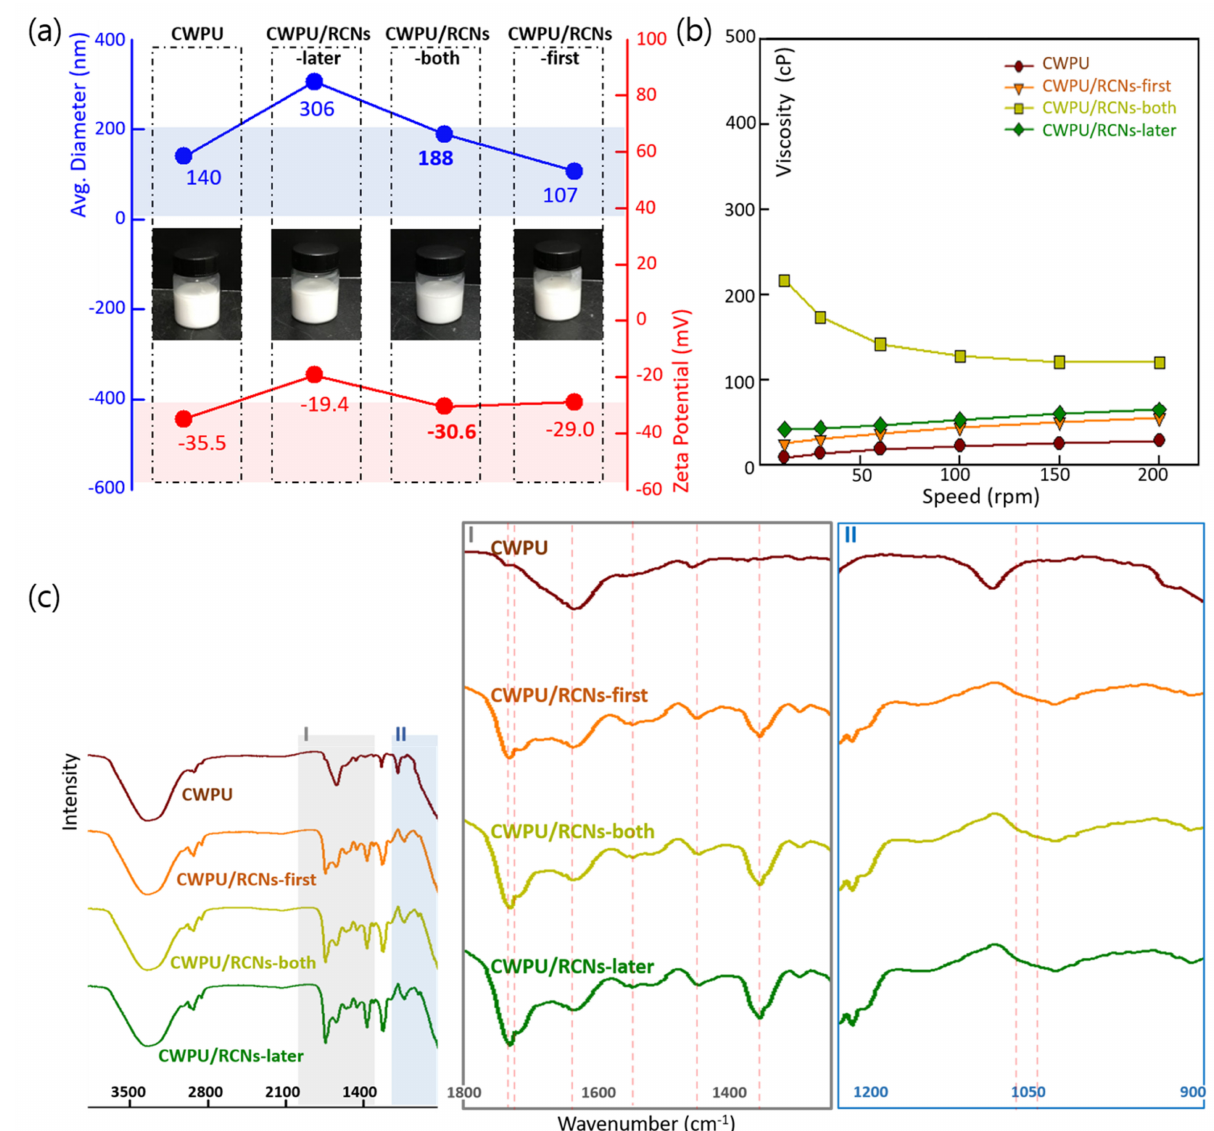
Figure 3. ( a ) Particle size and zeta potential, ( b ) viscosity, and ( c ) FT-IR spectra of CWPU and CWPU/RCNs dispersions according to the step of adding